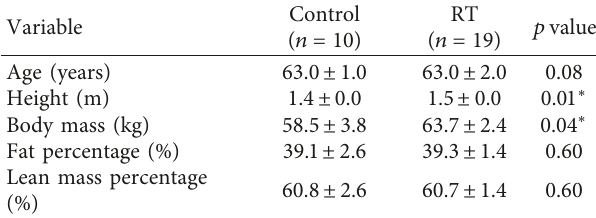
Table 1: Characteristics of study